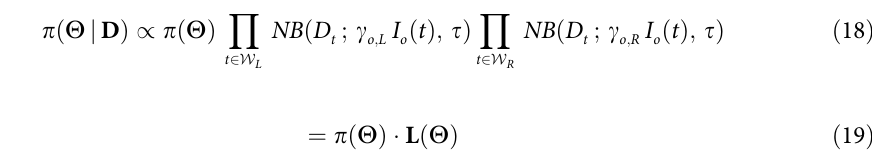
meters used to obtain the plots and inference in the Results section.